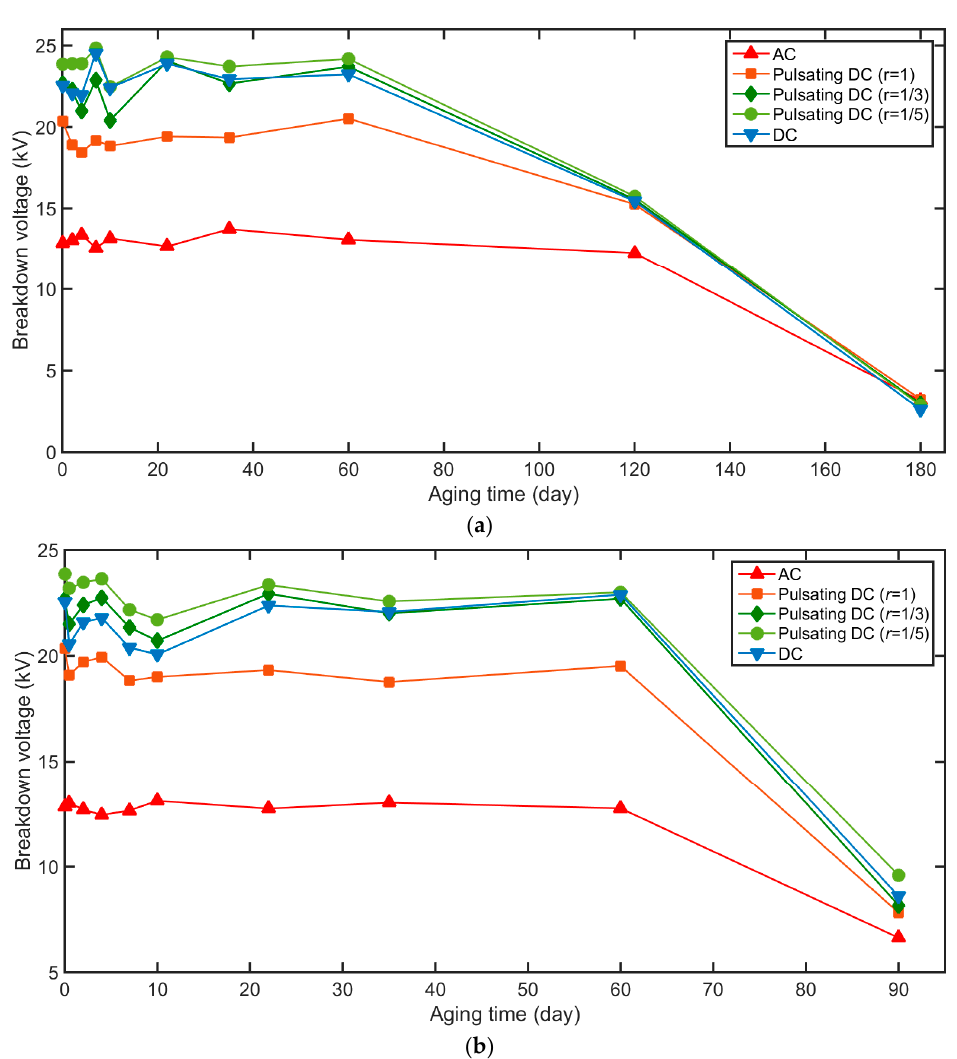
Figure 6. Breakdown voltage of OIP versus thermal aging time: ( a ) 120 °C; ( b ) 130 °C.